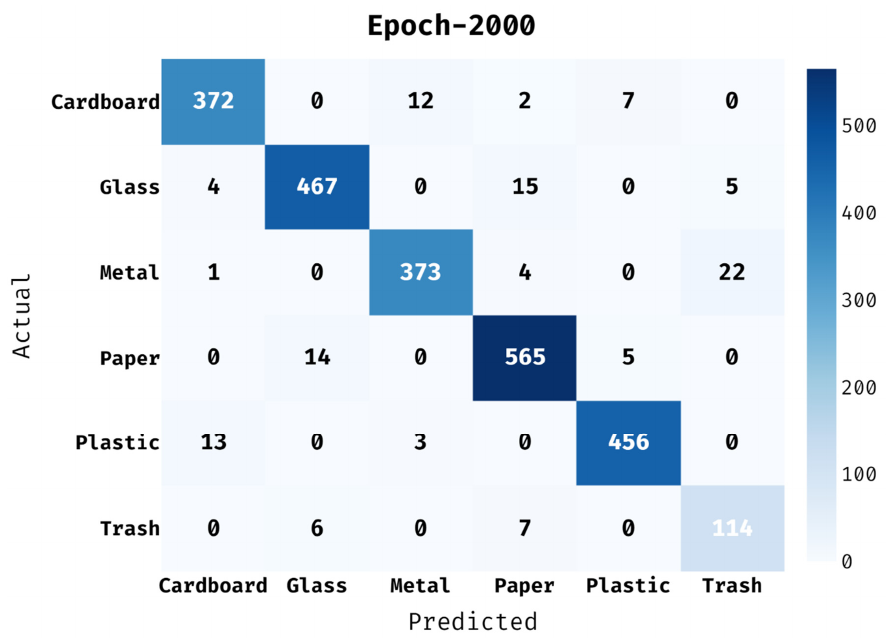
Figure 9. Confusion matrix of DLSODC-GWM technique under 2000 epochs.